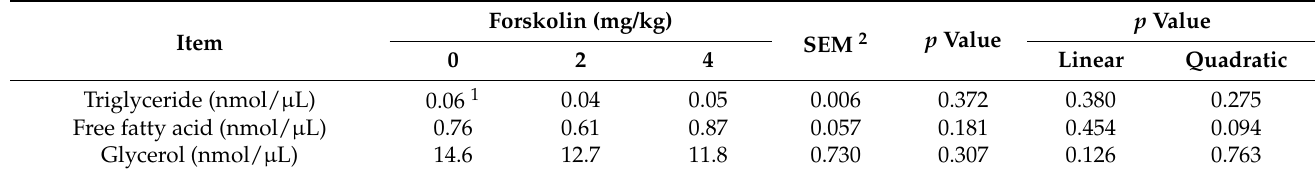
Figure 1. Effects of forskolin on body weight and feed intake of diet-induced obesity in mice. ( a ) Body weight of high-fat diet-fed mice in response to forskolin administration. Data are average body weight (g/mouse) of 8–11 mice per treatment. a p value = 0.067 by one-way ANOVA. b p value = 0.049 by linear contrasts. c p value = 0.096 by linear contrasts. ( b ) Average feed intake of high-fat diet-fed mice from the age of 10 to 16 weeks in response to forskolin administration. Data are average feed intake (g/mouse/day) of 8–11 mice per treatment. Table 1. Effect of forskolin on serum lipid profile of diet-induced obesity in mice.